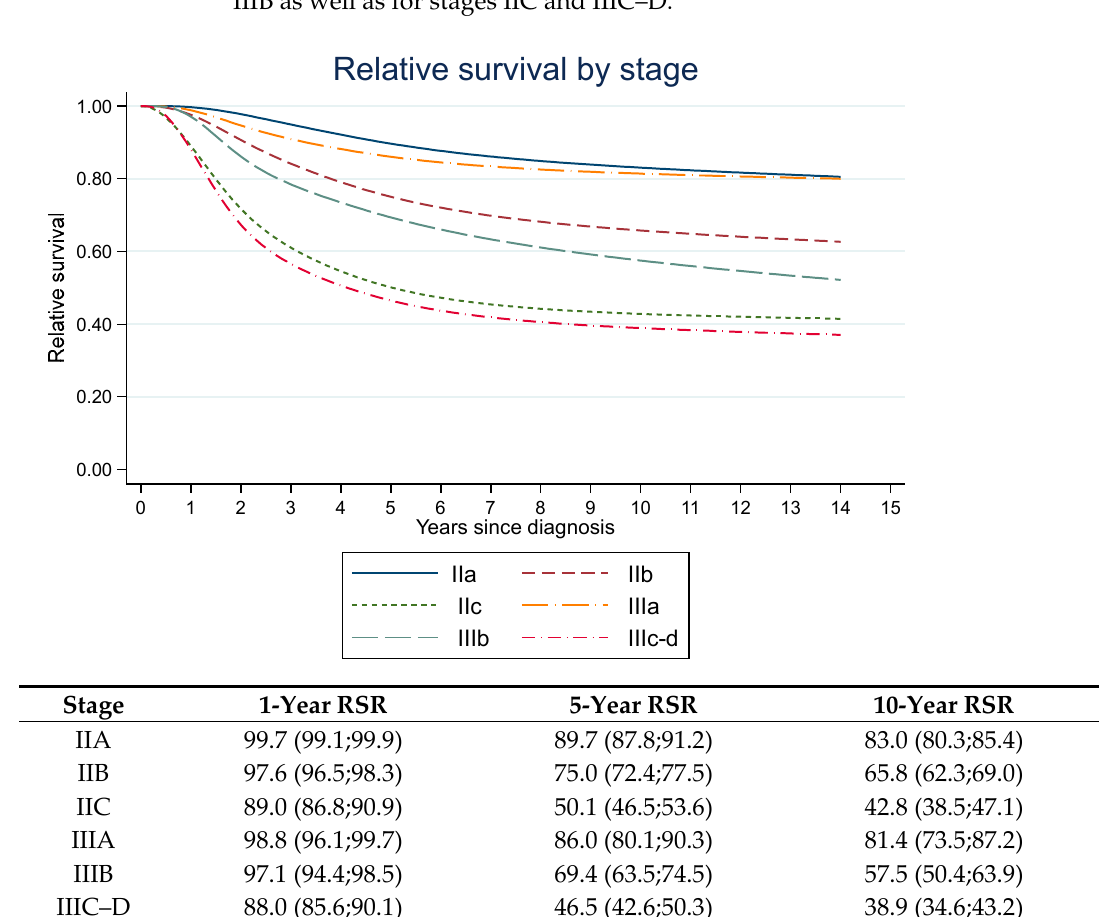
Figure 1. Cumulative relative survival by stage for patients diagnosed with stage II–III cutaneous melanoma in Sweden, 2005–2013.